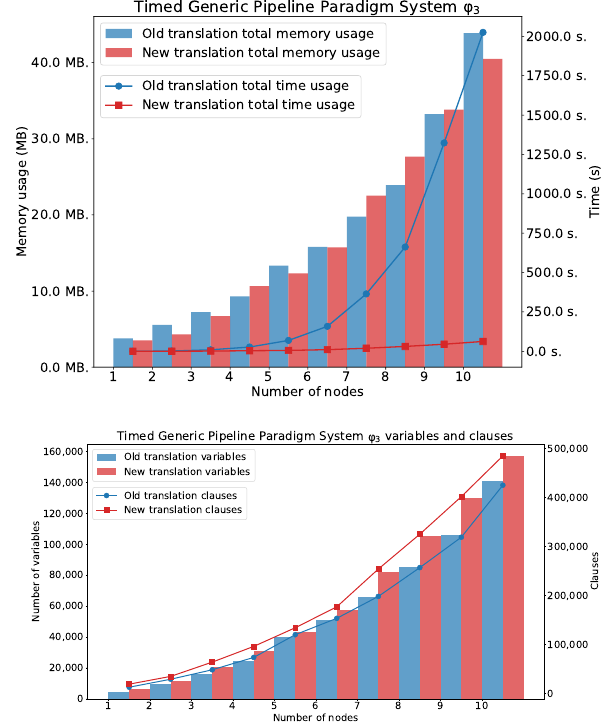
Figure 10. Results for ϕ 3 : TGPP with n nodes. Number of variables and clauses for ϕ 3